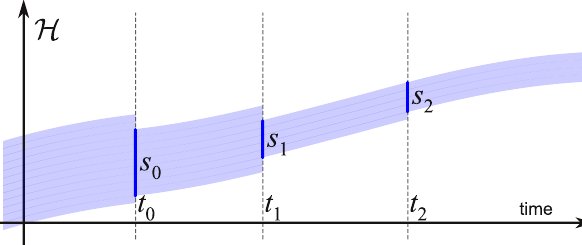
Figure 1: Delayed initial conditions. Each event reduces the set of solutions compatible with the already happened